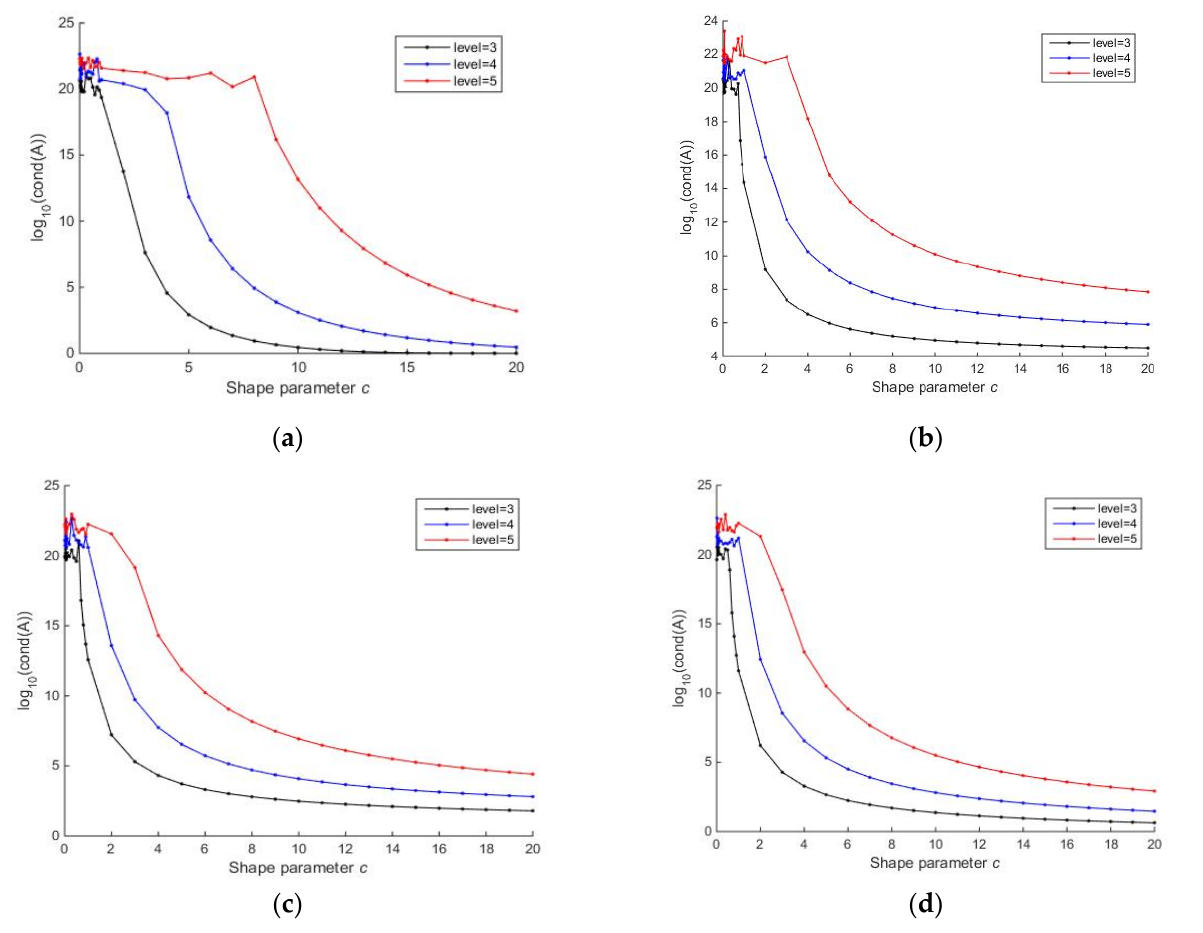
Figure 5. Log 10 cond(A) as a function of shape parameter c ( a ) when global RBF based on Gauss basis function is utilized for interpolation; ( b ) when global RBF based on MQ basis function is utilized for interpolation; ( c ) when global RBF based on IMQ basis function is utilized for interpolation; ( d ) when global RBF based on IQ basis function is utilized for interpolation.